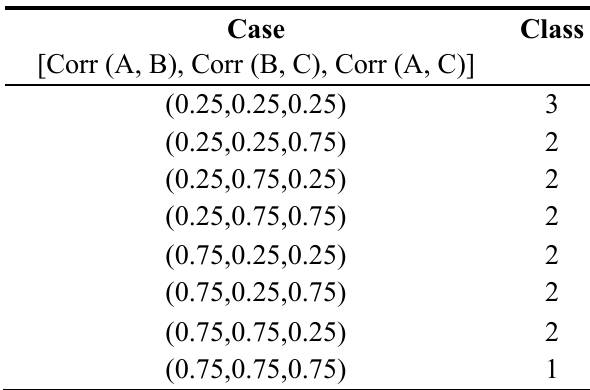
Table 3. Training 3D RBF